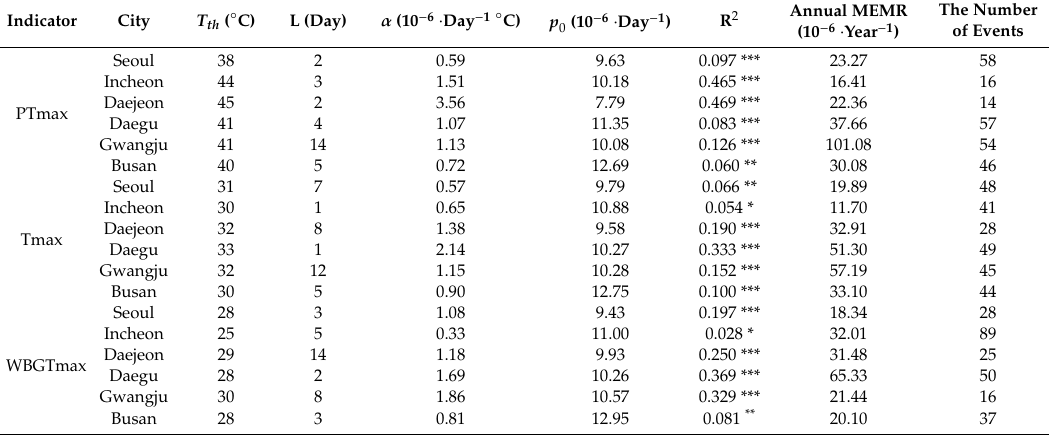
Table 2. Estimated free parameters, coefficient of determination, and annual mean excess mortality rate (MEMR) for the fitted heat-related risk assessment model depending on the regions during the training period (2000–2016).